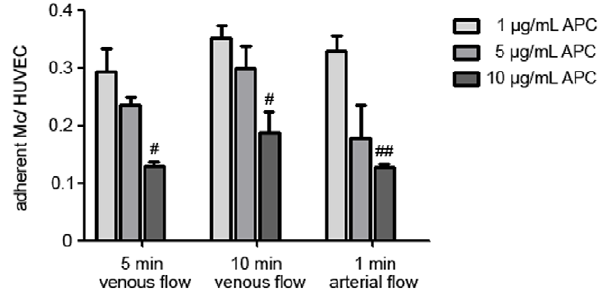
Figure 5. Blockade of monocyte binding to endothelial cells by APC in different concentrations under flow conditions. Mono- cyte binding to HUVECs in dynamic adhesion assays after 5 min (left) and 10 min venous flow (middle), and after 1 min arterial flow (right). Pre-treatment of HUVECs with 10 m g/mL activated protein C (drotre- cogin alfa) (dark grey bars) diminished monocyte adhesion compared to 1 m g/mL (light grey bars) and 5 m g/mL (grey bars) drotrecogin alfa. ( ## p , 0.005; # p , 0.05 vs. 1 m g/mL APC).